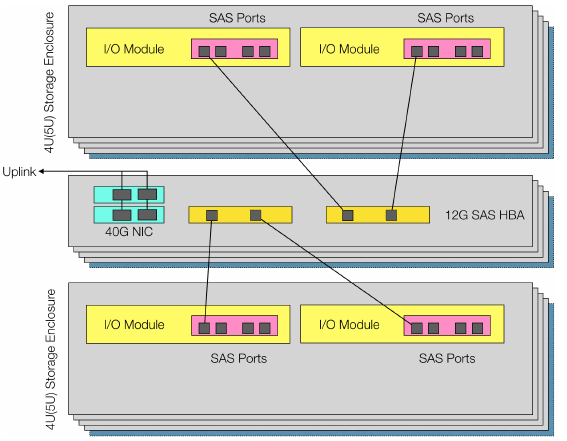
Figure 1. The schematic view of physical connection of JBOD enclosures and front-end nodes. Each of two SAS HBA controllers are connecting to JBOD storage enclosures in dual-domain